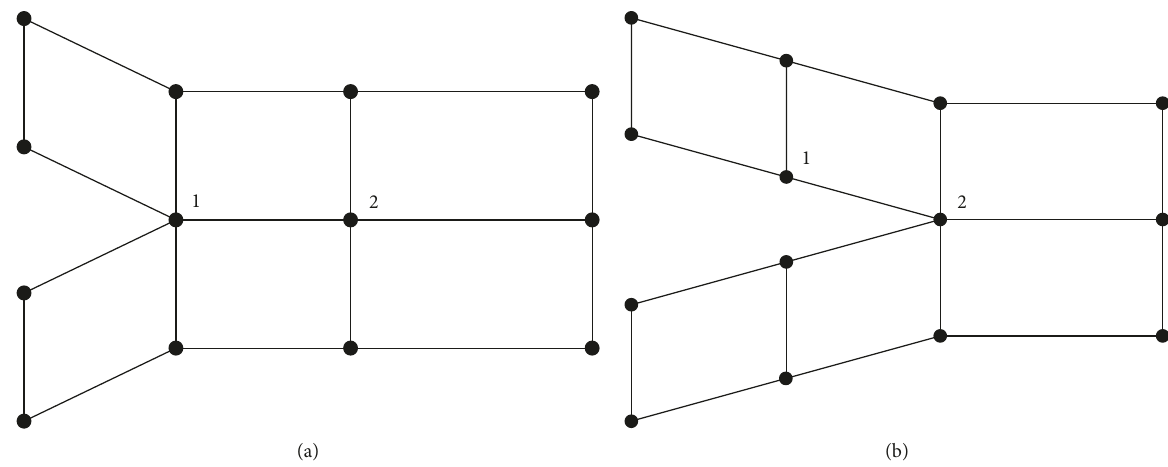
Figure 6: Process of crack propagation. (a) Before crack propagation. (b) After crack